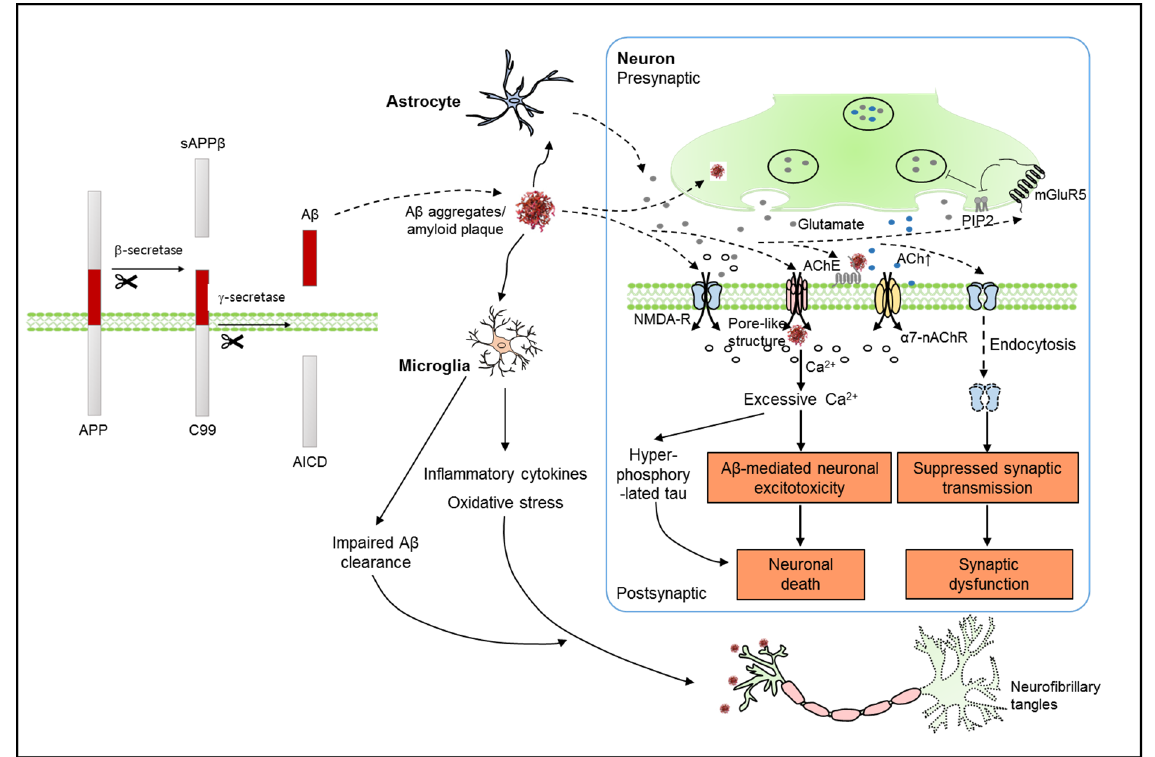
Figure 1. Schematic representation of the amyloid hypothesis for AD pathology. Amyloid beta (A β ), generated by the aberrant sequential cleavage of APP, aggregates to form extracellular amyloid plaques. As a trigger, A β induces toxic amounts of Ca 2+ influx through the activation of postsynaptic NMDA receptors or pore-like structures generated by A β . A β inhibits the activity of AChE and increases ACh levels in the synaptic cleft, contributing to excessive intracellular Ca 2+ concentration. High levels of intracellular Ca 2+ mediate a series of downstream signaling pathways related to neuronal excitotoxicity. A β -initiated hyperphosphorylated tau results in neuronal death. On the other hand, A β mediates synaptic dysfunction by inducing endocytosis of postsynaptic NMDA receptors or presynaptic mGluR5-mediated depletion of PIP 2 , which decreases neurotransmission. A β -induced activation of astrocytes and microglia contributes to neuronal degeneration in AD through excitotoxicity, neuroinflammation, oxidative stress, and impaired A β clearance.